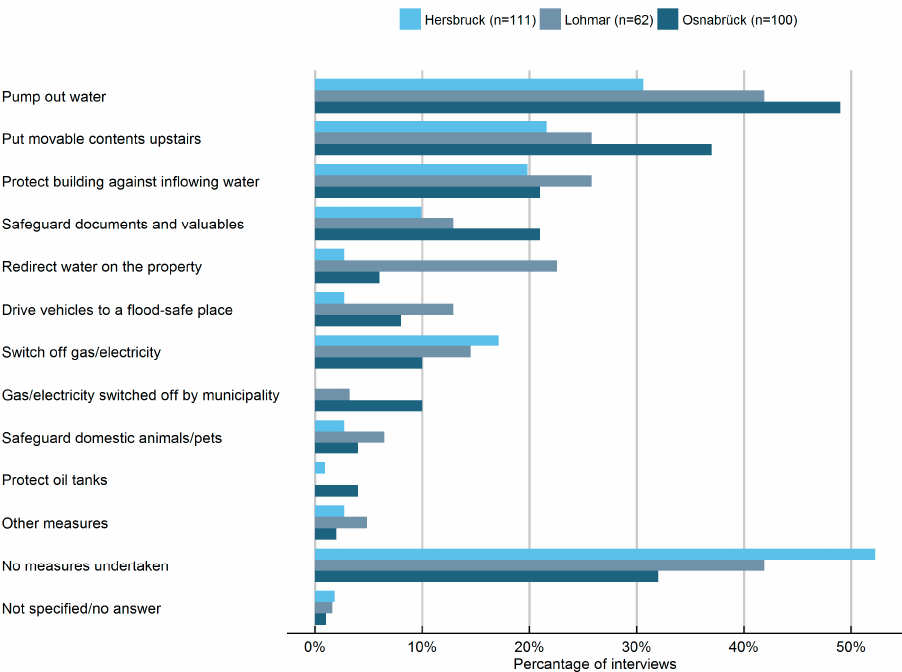
Figure 5. Fraction of interviewed households that performed emergency measures shortly before or during the pluvial flood event.